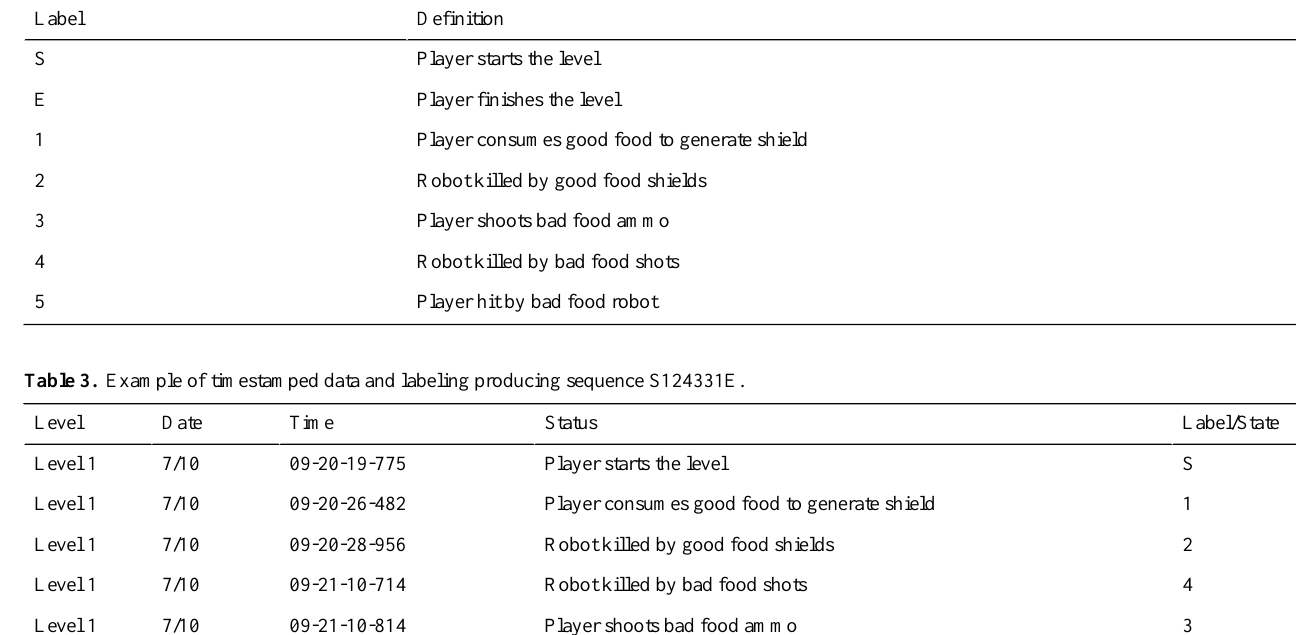
Table 2. Definitions of each feature label.